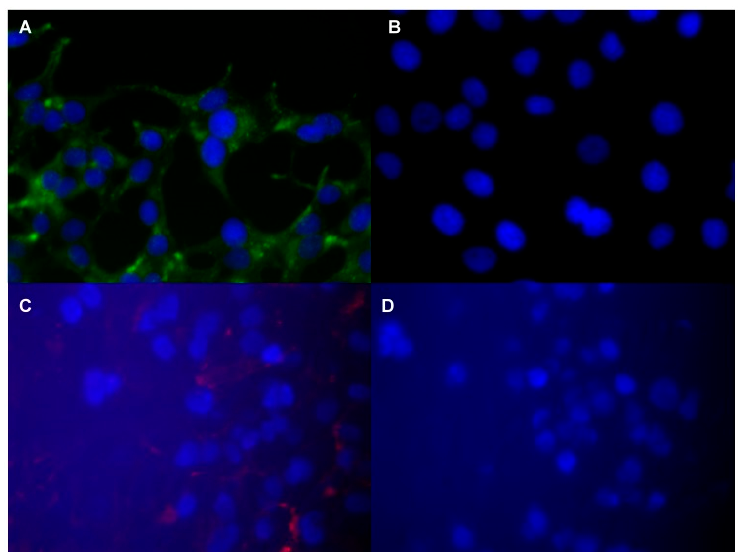
Figure 5. Fluorescence microscopic images of prostate specific tumor cells with muJ591:MIRB from Bates et al. (2014); The images show antibody staining. ( A ) Extracellular and subcellular area LNCaP cells. ( B ) DU145 cells as negative control. ( C ) Rhodamine-B fluorophore detection (red) on LNCaP cells. ( D ) DU145 cells as negative control for detection.